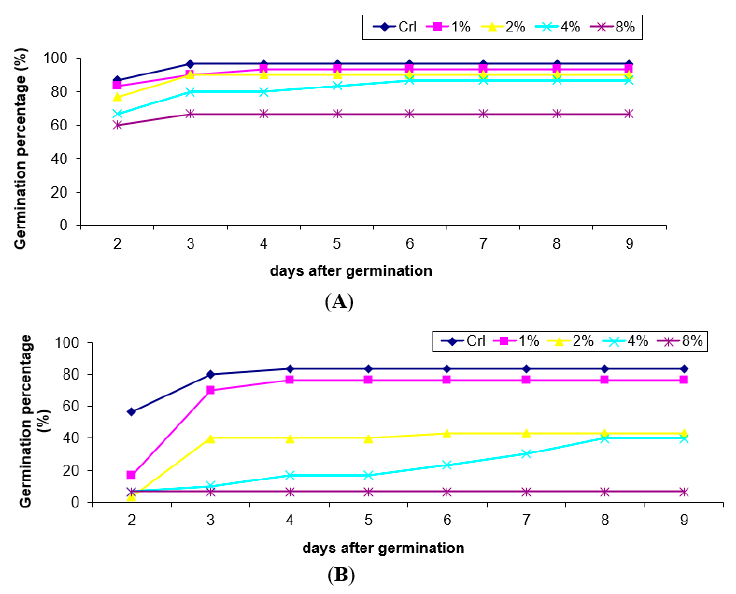
Figure 1. Effect of the aqueous extract of H. persicum on the germination rate of wheat ( A ) and black mustard ( B ).